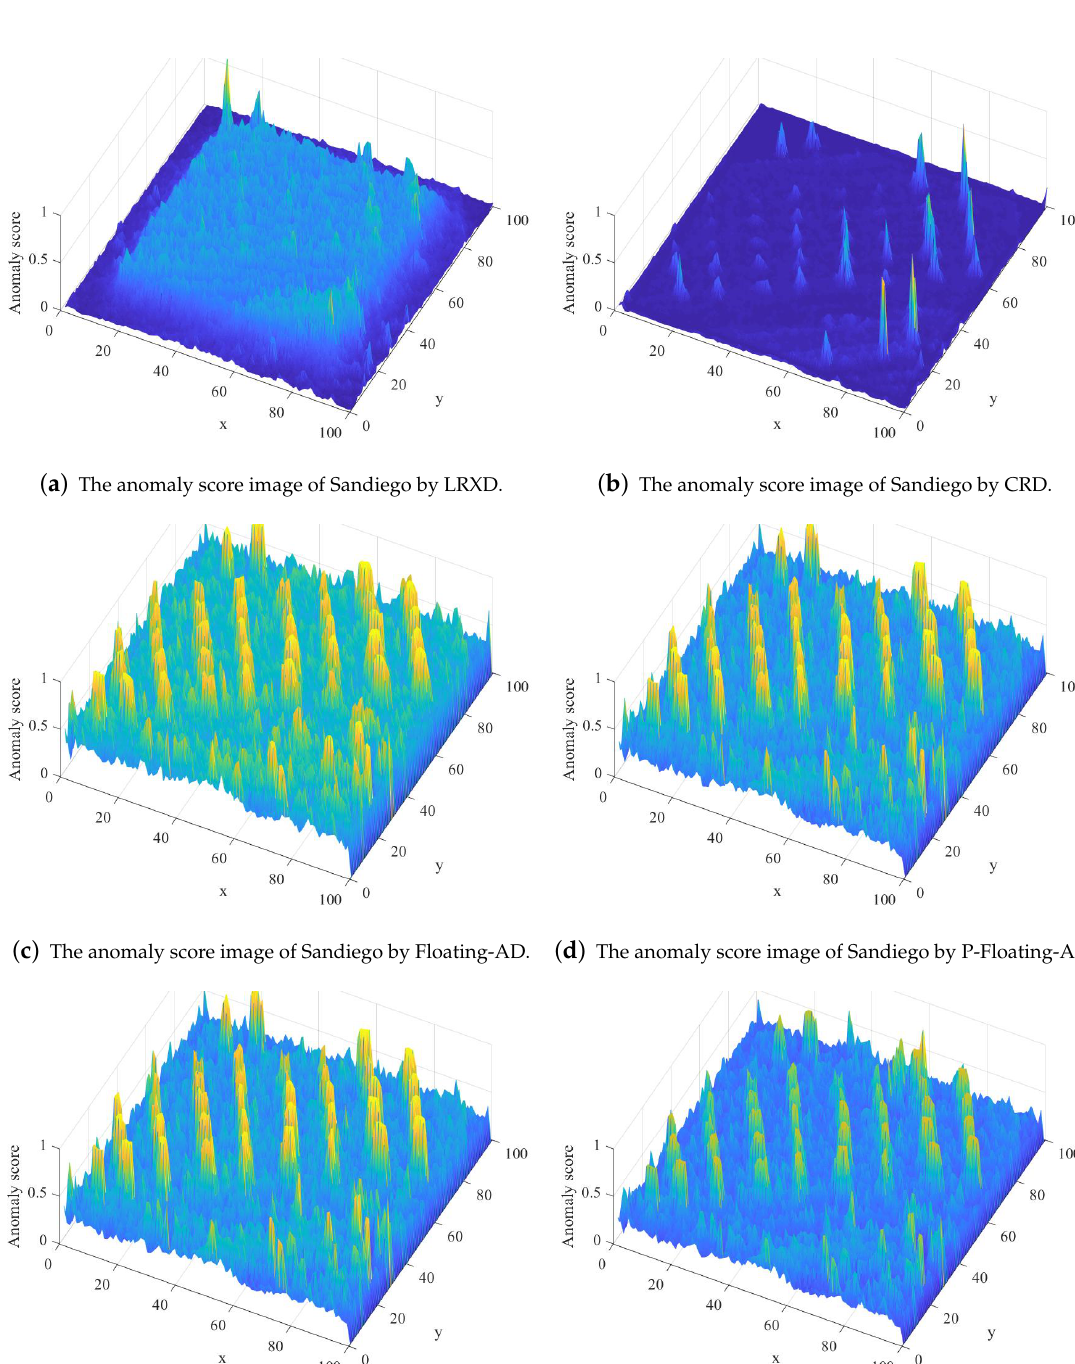
( e ) The anomaly score image of Sandiego by P-Fixed-AD. ( f ) The anomaly score image of Sandiego by P-Q-AD. Figure 19. The detection results for Sandiego data